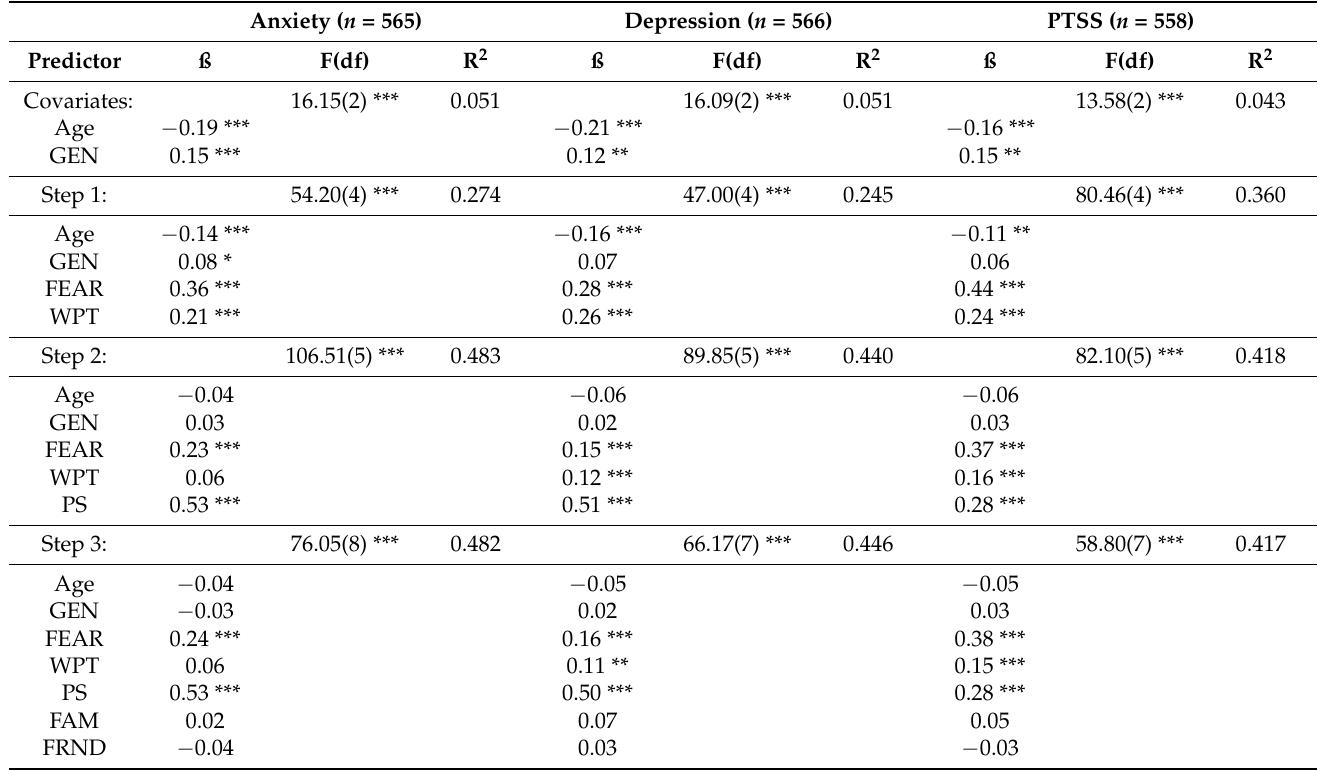
Table 5. Summary of hierarchical linear regression models predicting MH